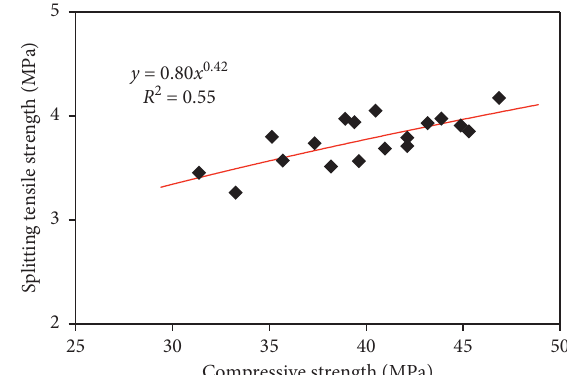
Figure 16: Correlation between splitting tensile strength and compressive strength of the mixes with RCA.